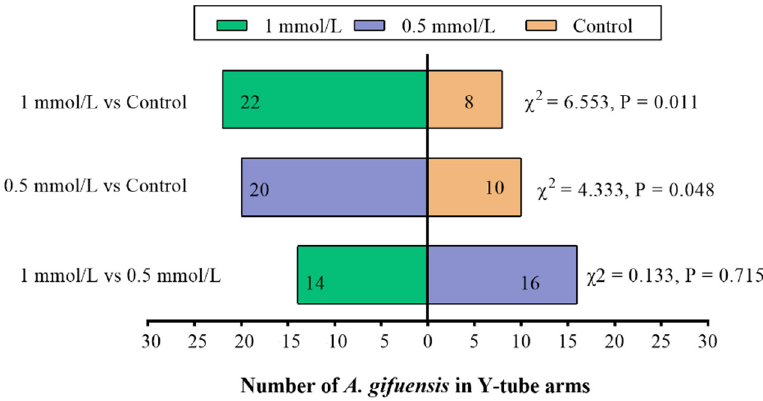
Figure 2. Responses of female Aphidius gifuensis (n = 30) in a Y-tube olfactometer between the arm with the untreated plant extracts and the arm treated with either 1 mmol/L MeSA or the 0.5 mmol/L MeSA plant extracts.